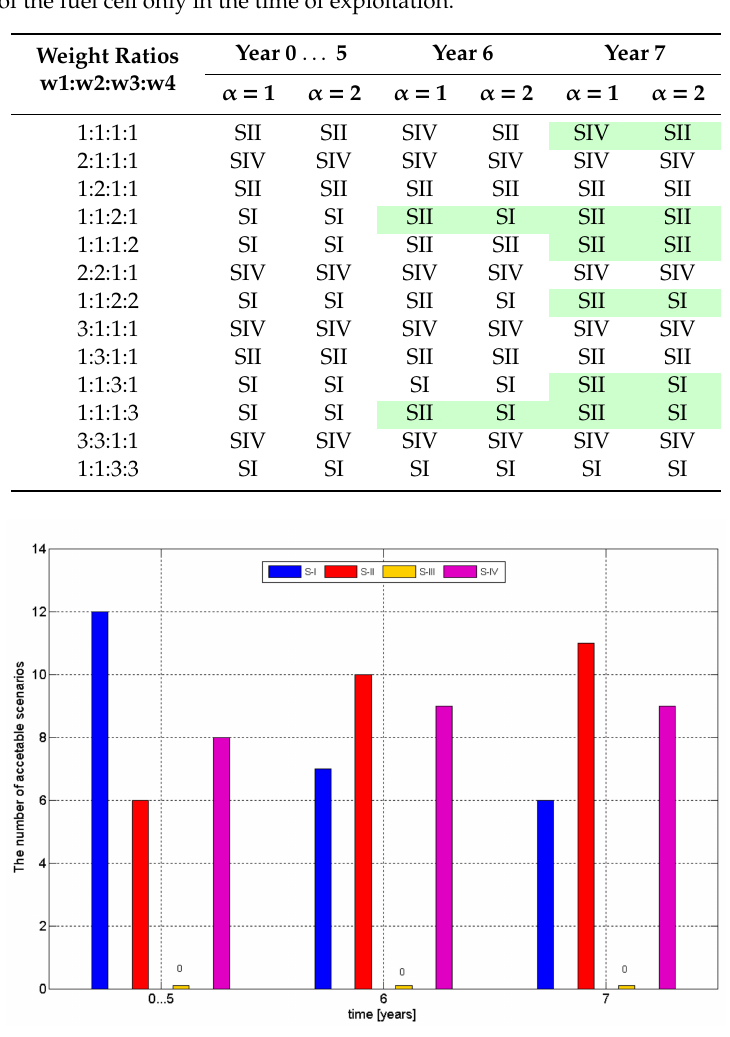
Figure 13. Results of the multi-criteria analysis of load distribution taking into account a decrease in the performance of the fuel cell alone in the time of